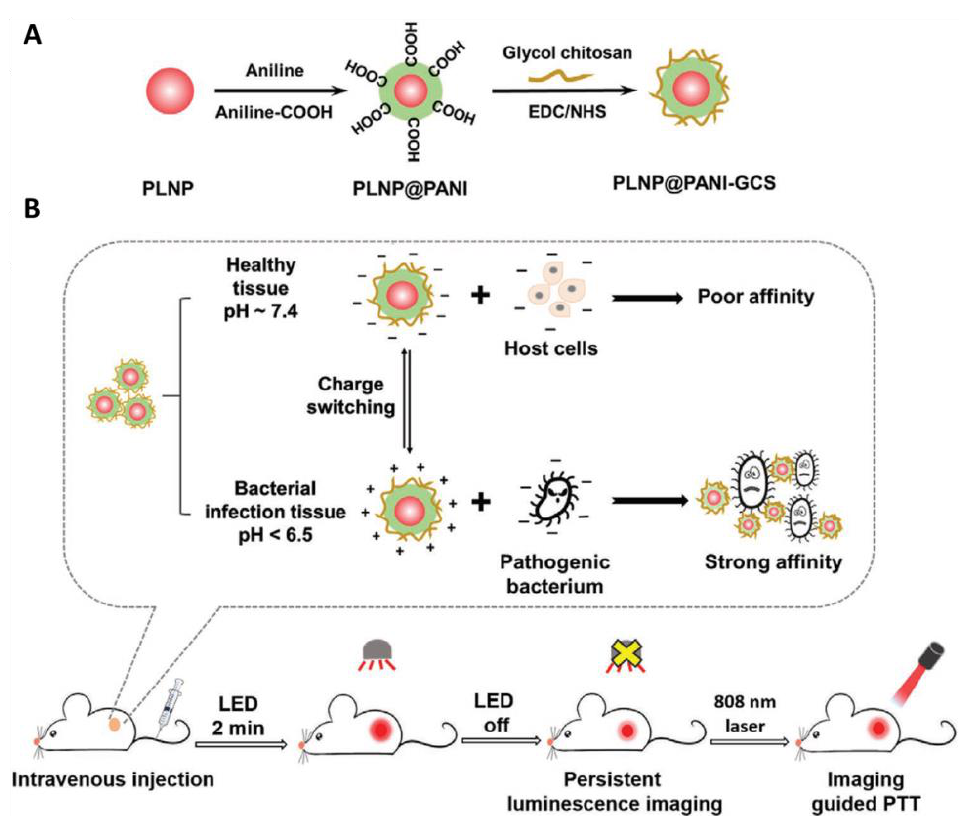
Figure 7. ( A ) Preparation of PLNP@PANI-GCS. ( B ) Illustration of PLNP@PANI-GCS for persistent luminescence imaging-guided photothermal therapy of bacterial infection (images are reproduced from [97] with the copyright permission from WILEY-VCH Verlag GmbH & Co.).